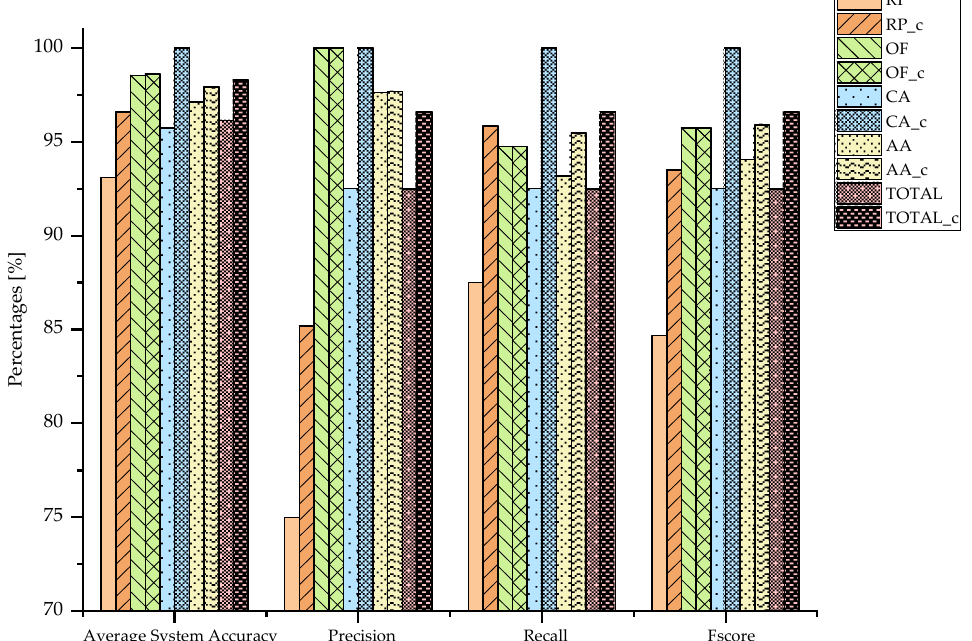
Figure 4. Comparison between model performances on TS + VS dataset, per each class, before (RP, OF, CA, AA, TOTAL) and after (RP_c, OF_c, CA_c, AA_c, TOTAL_c) the application of correction coeffi-